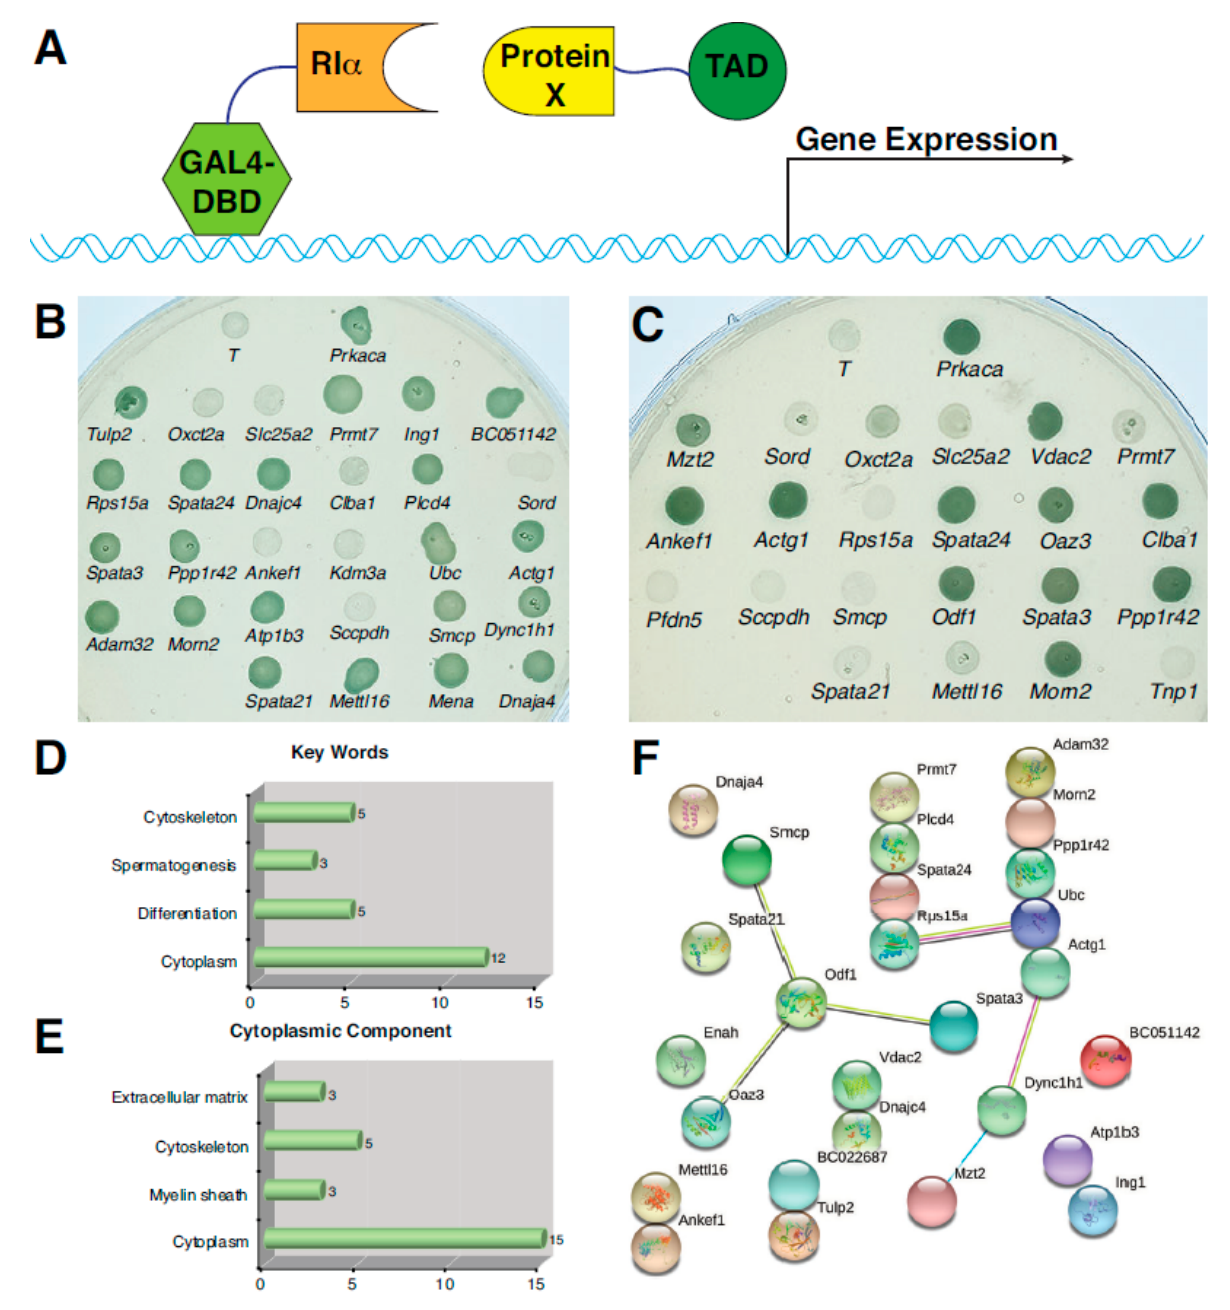
Figure 2. Yeast two-hybrid screen of PKA-RI α interacting proteins. ( A ) Schematic of yeast two-hybrid screen. ( B ) Secondary Y2H screen of partial cDNA clones. Green colonies are positive clones that showed interactions with bait Prkar1a on the quadruple drop-out QDO/X/A plates. Prkaca and T were used as positive and negative controls, respectively. ( C ) Secondary Y2H screen of full-length cDNA clones. Green colonies are positive clones that showed interaction with bait Prkar1a on the quadruple drop-out QDO/X/A plates. Prkaca and T were used as positive and negative controls, respectively. ( D , E ) GO analysis of proteins that showed positive interactions with PKA-RI α during the Y2H screen. ( F ) String analysis of putative PKA-RI α interacting proteins.